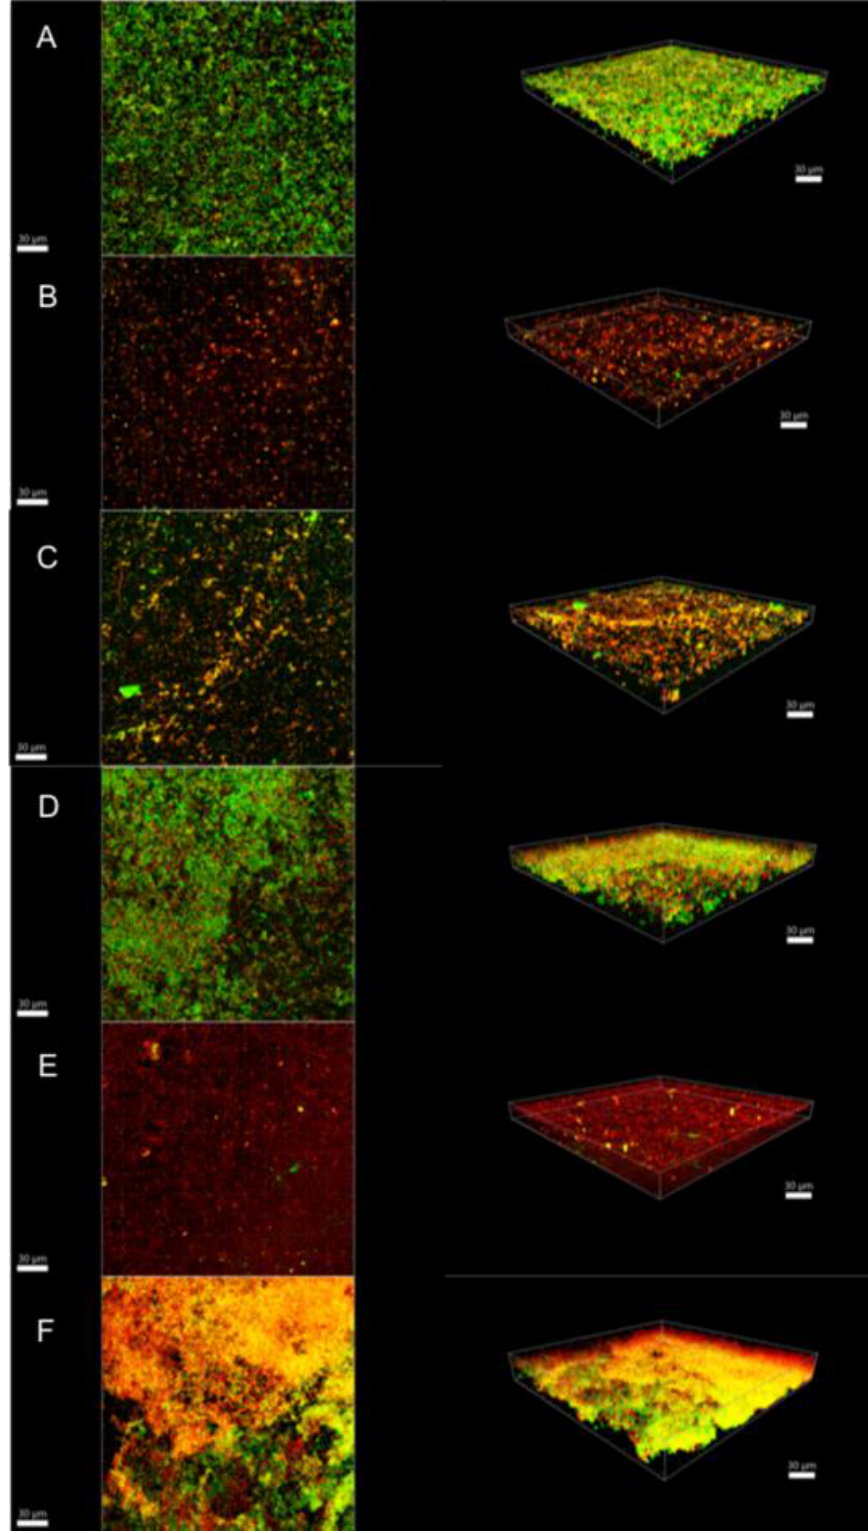
Figure 2. Confocal laser scanning microscopy images of 3-day biofilms. ( A ) Saline; ( B ) 1.5% NaOCl; ( C ) 17% EDTA; ( D ) high-purity nisin; ( E ) 1.5% NaOCl + high-purity nisin and ( F ) 17% EDTA + high-purity nisin. The biofilms were stained using the LIVE/DEAD Viability Kit; live cells appear green and dead cells red. Images represent the 3D reconstructions of the biofilms using IMARIS 7.6.5 software (orthogonal and perspective views from left to right). Scale bar 30 μm.